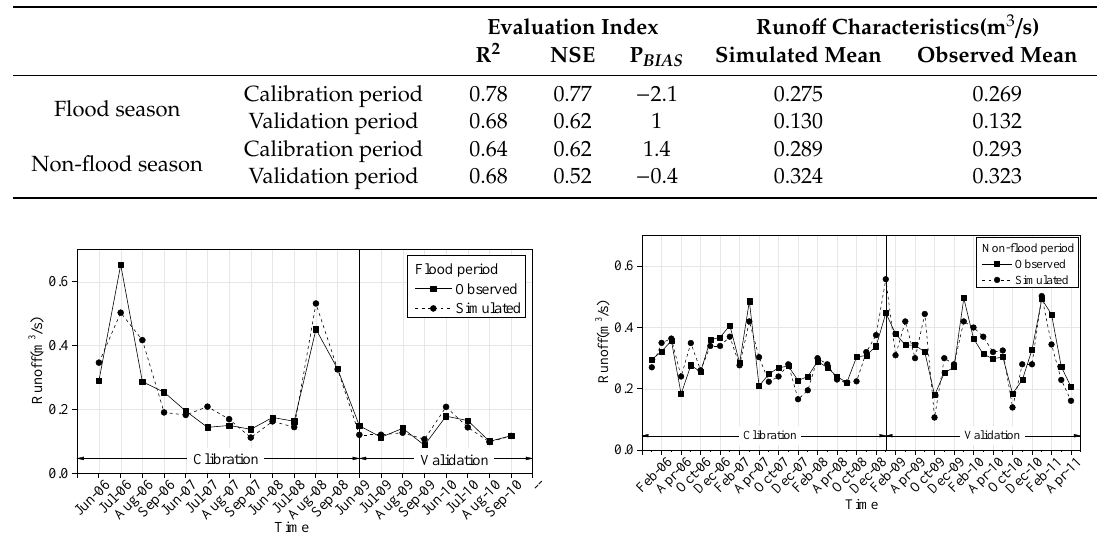
Figure 3. Comparison between simulated value and observed value in different periods.